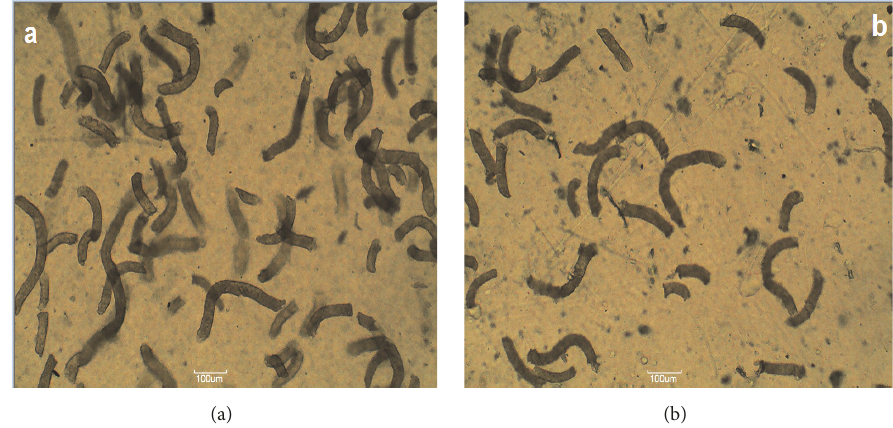
Figure 9: Optical micrographs of (a) 5 wt% t-PAfs/PP composite and (b) 5 wt% t-PAfs/5wt% f-Na-MMT/PP hybrid composite.